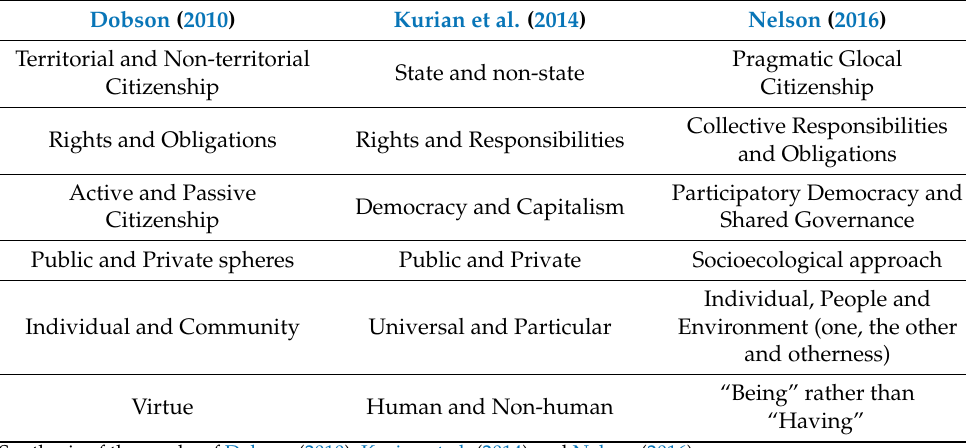
Table 1. Examples of key dimensions of sustainable